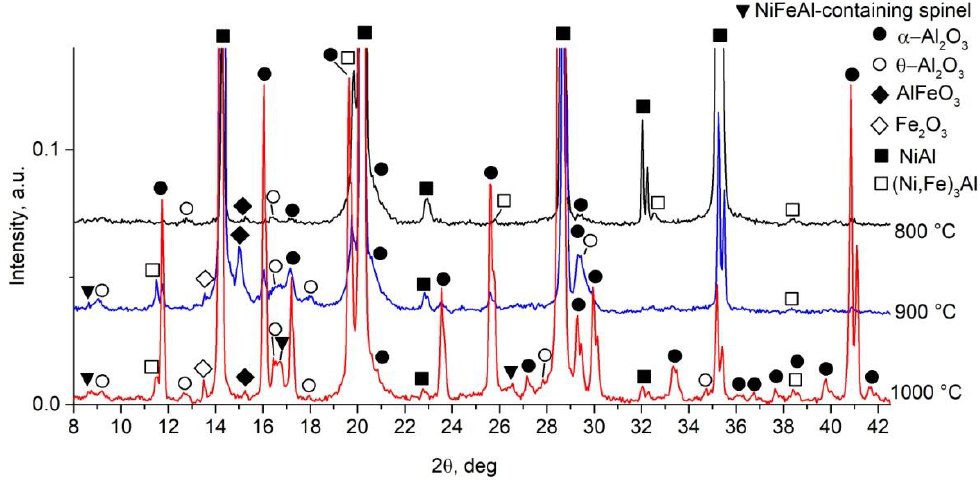
Figure 10. XRD patterns of NiAl-based coatings after oxidation tests of 100 h at 800, 900, and 1000 °C.